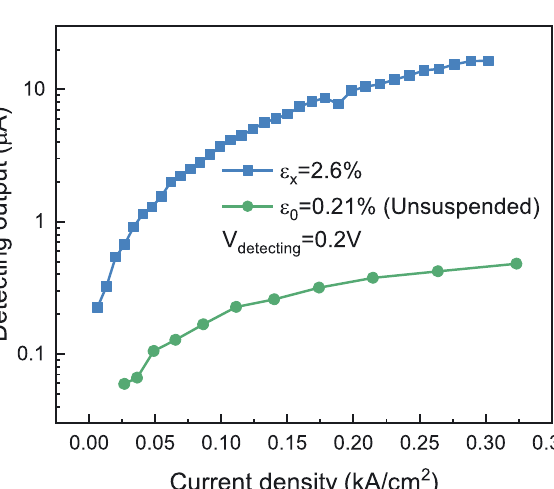
Figure 7: Schematic of the experimental set- up, highlighting the main elements: Lock-in amplifier, function signal generator, digital source meter, resistance of 50 Ω , device withemitting-detectingcon fi gurationunder test on the thermo electric cooler (TEC).